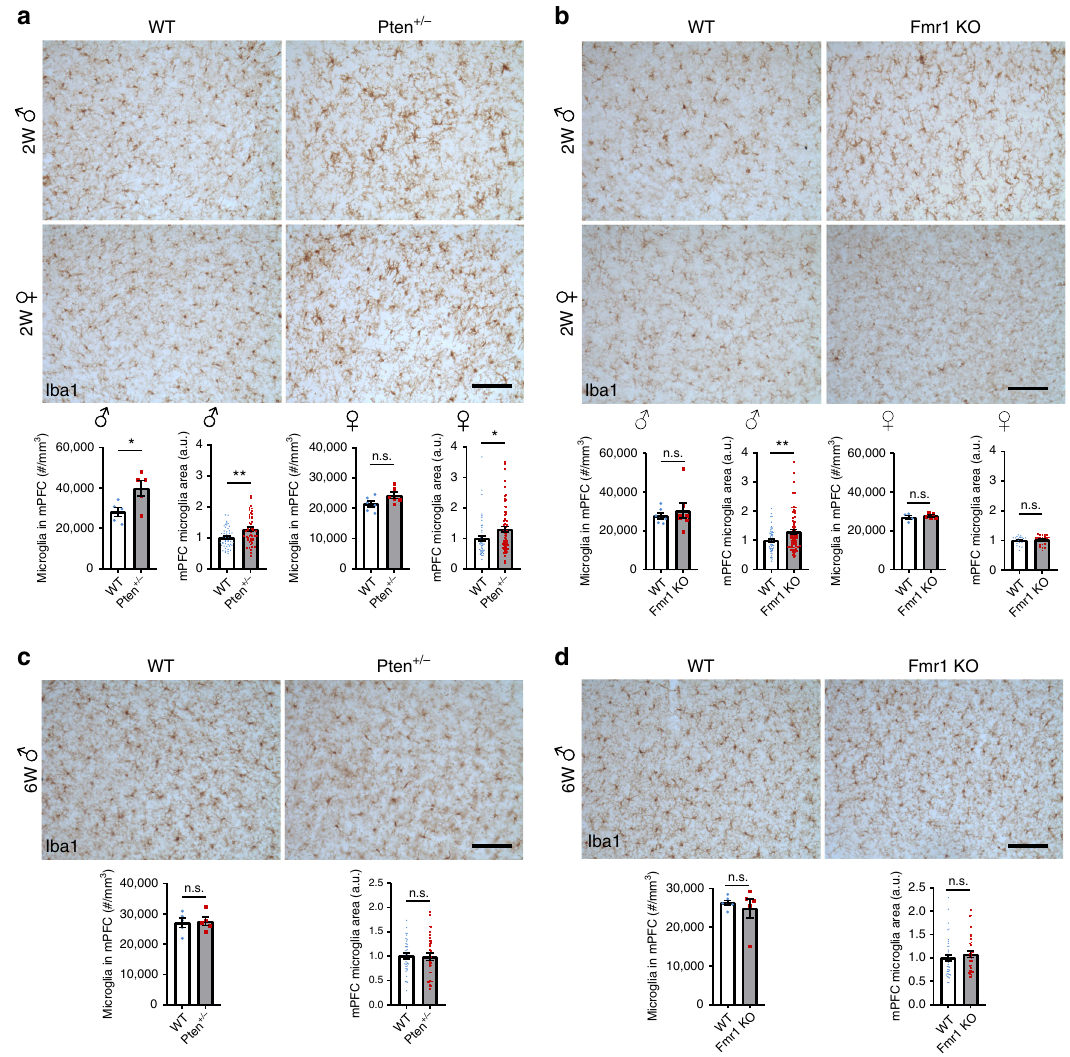
Fig. 4 Altered microglial density and size in Pten + / − and Fmr1 KO mice. a Microglial density and size in the mPFC of 2-week-old male and female Pten + /- mice. Male, n = 5 mice per genotype. Female, n = 6 mice per genotype. Five to ten microglia from each condition were randomly selected for measurement of cell size (cross section area). Two-sided t -test: male, cell density * p = 0.0317, cell size ** p = 0.001; female, cell density p = 0.0725, cell size * p = 0.0232, n.s. not signi fi cant. Scale bar, 100 µ m. b Microglial density and size in the mPFC of 2-week-old male and female Fmr1 KO mice. Male, n = 7 mice per genotype. Female, n = 4 WT mice and 5 KO mice. 5-10 microglia from each condition were randomly selected for measurement of cell size (cross section area). Two-sided t- test: ** p = 0.0046, and n.s. not signi fi cant. Scale bar, 100 µ m. c , d Microglial density and size in the mPFC of 6-week-old male Pten + / − ( c ) and Fmr1 KO ( d ) mice. c n = 5 mice per condition; d n = 6 WT mice and 5 Fmr1 KO mice. Five to ten microglia from each condition were randomly selected for measurement of cell size (cross section area). n.s., not signi fi cant by two-sided t -test. Scale bar, 100 μ m. All data are shown as mean ± s.e.m. Source data are provided as a Source Data fi